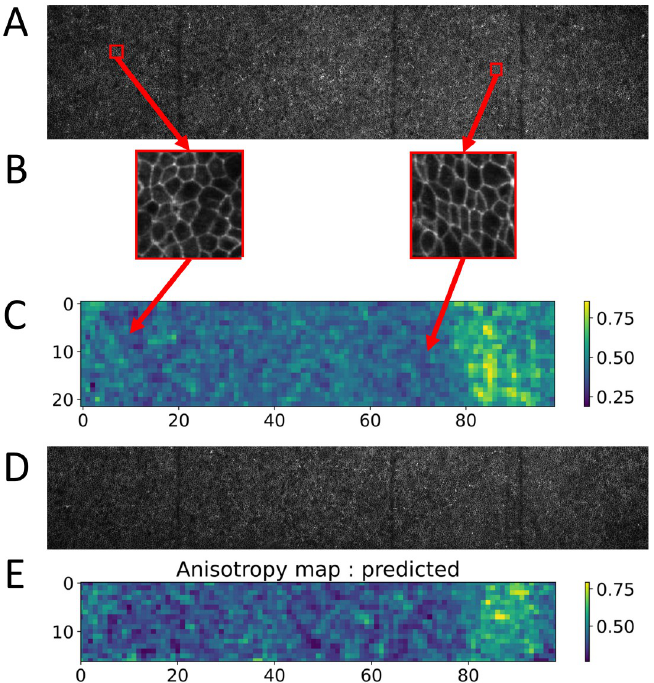
Fig 9. Illustration of strategy. A: Original image used to create a training set. It is the top part of a larger image which was separated in two. B: two examples of 128 � 128 images extracted from A. C: anisotropy map of the full image, each image in B represents one pixel of this map. D: Original image used to create a test set which was separated in similar 128 � 128 windows and these images were passed to the trained CNN. E: Predicted anisotropy map of the image in D. Comparing the ground truth in C and predicted anisotropy maps in